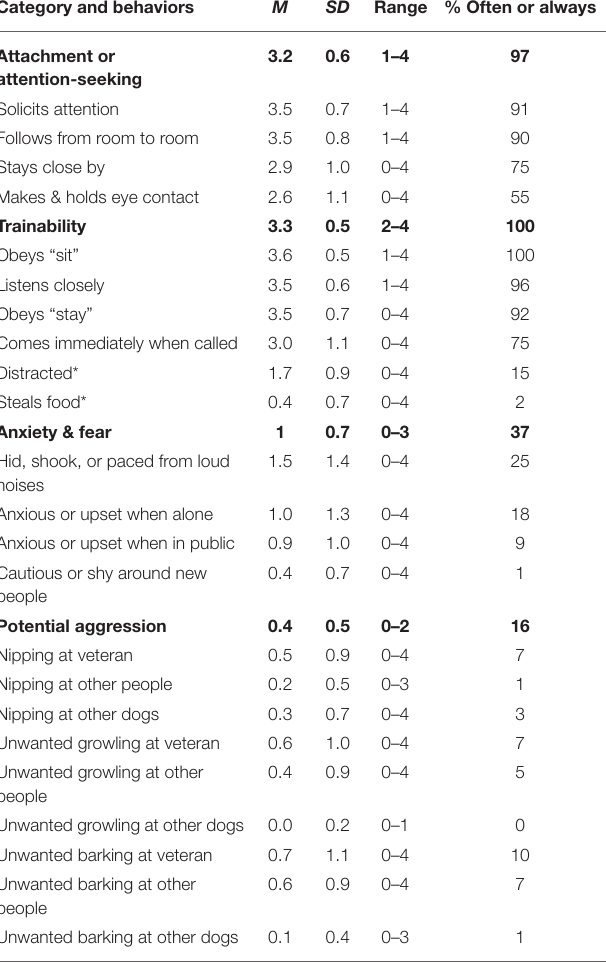
TABLE 3 | Service dog